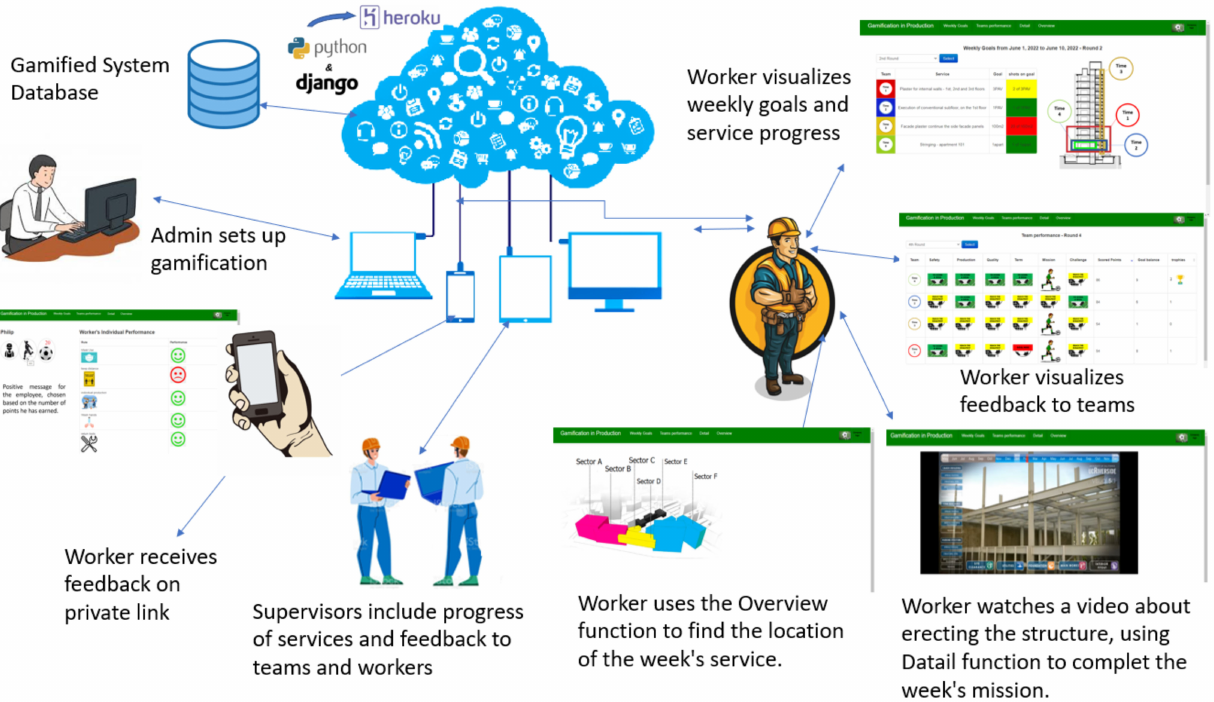
Figure 5. Information flow in construction